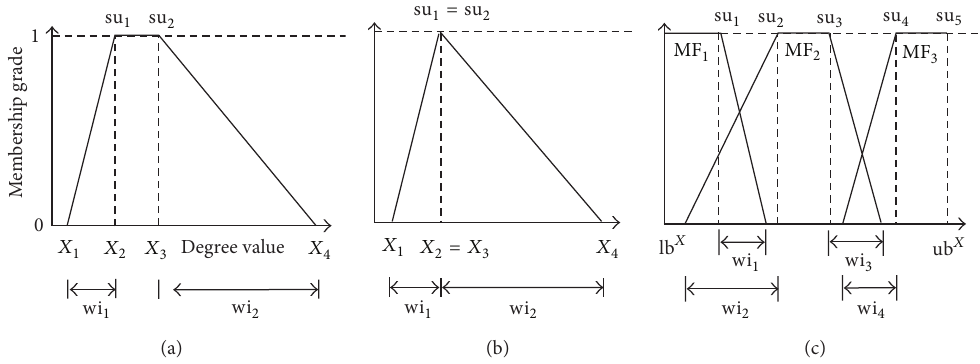
Figure 3: Membership functions: (a) trapezoidal MF; (b) special case of trapezoidal MF; (c) complete MF Set.